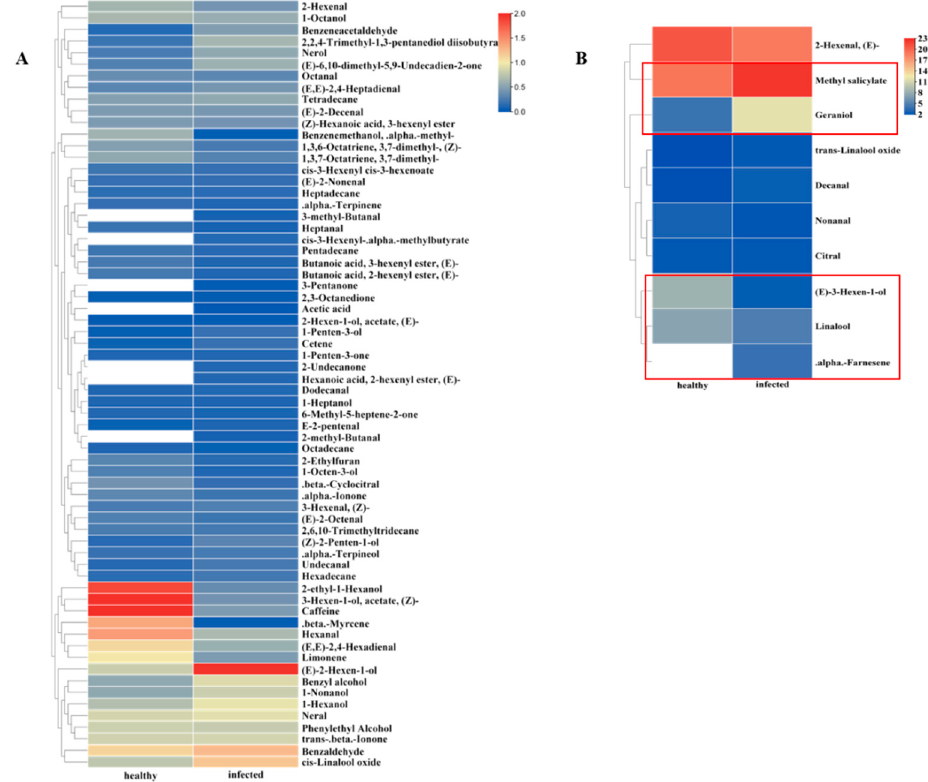
Figure 2. Heat map analysis of relative percentage of healthy and infected on “Baiye No.1” ( A ) shows the volatile content less than 2%; ( B ) The volatiles in the red boxes show the volatile content greater than 2%.